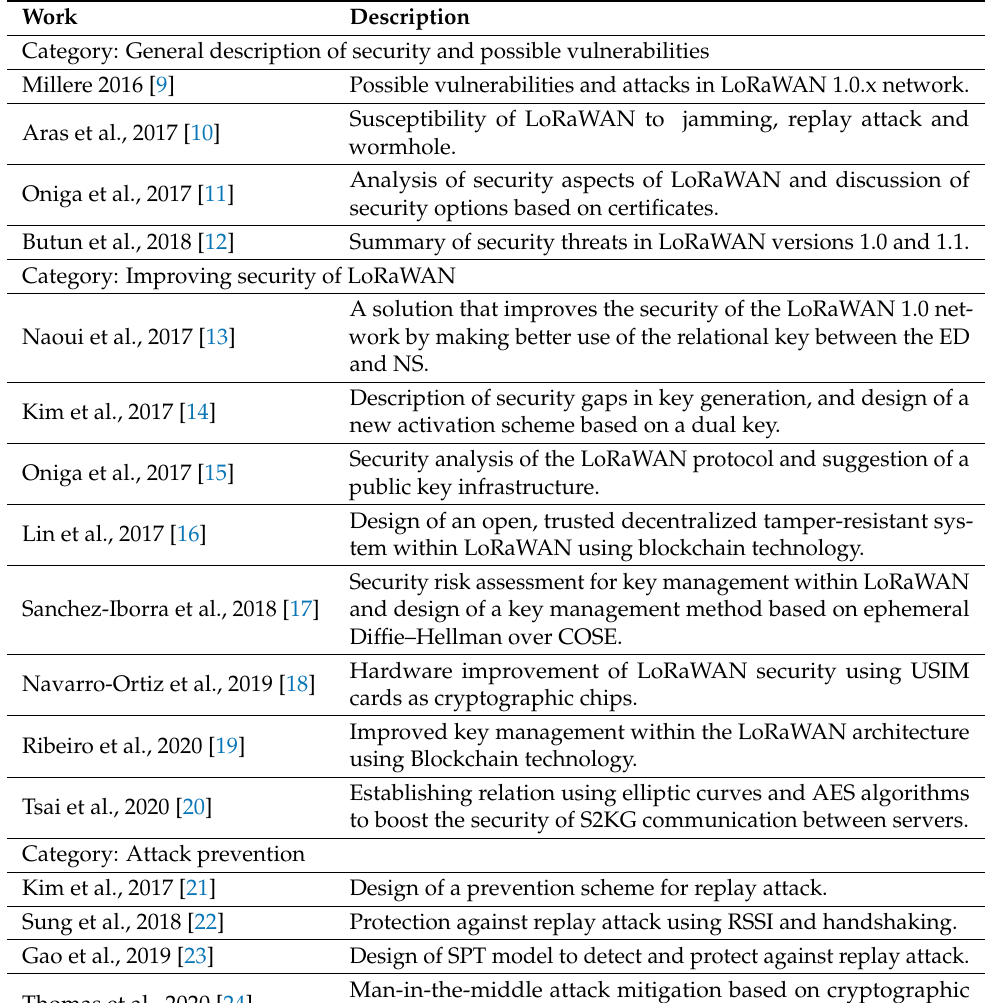
Table 1. Summary of selected articles on LoRaWAN cyber